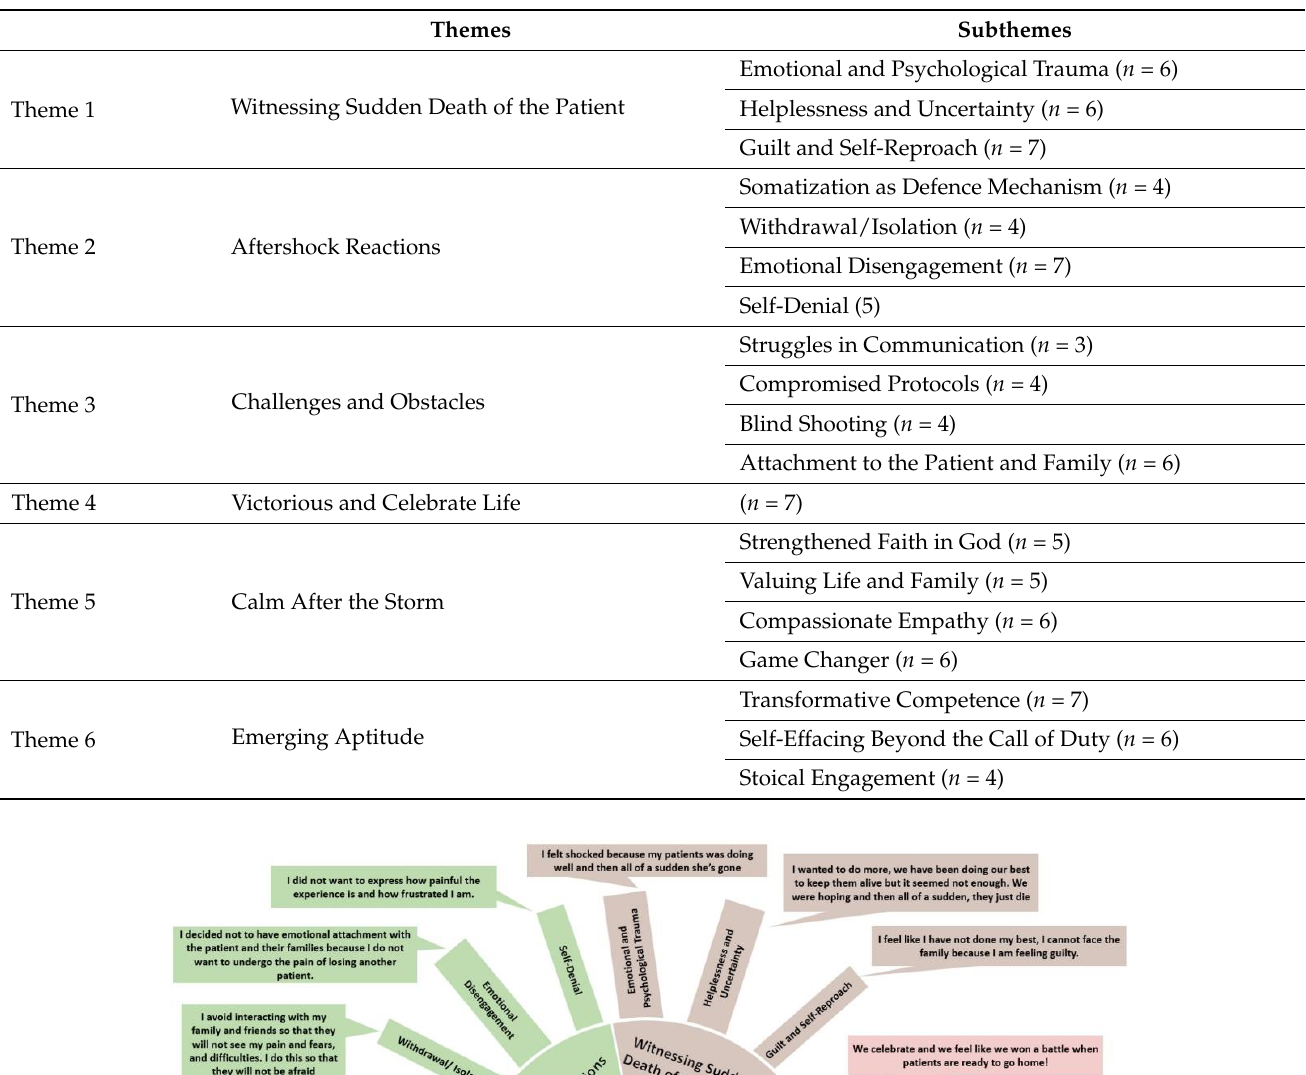
Table 1. Emerged themes and subthemes ( n = 7).